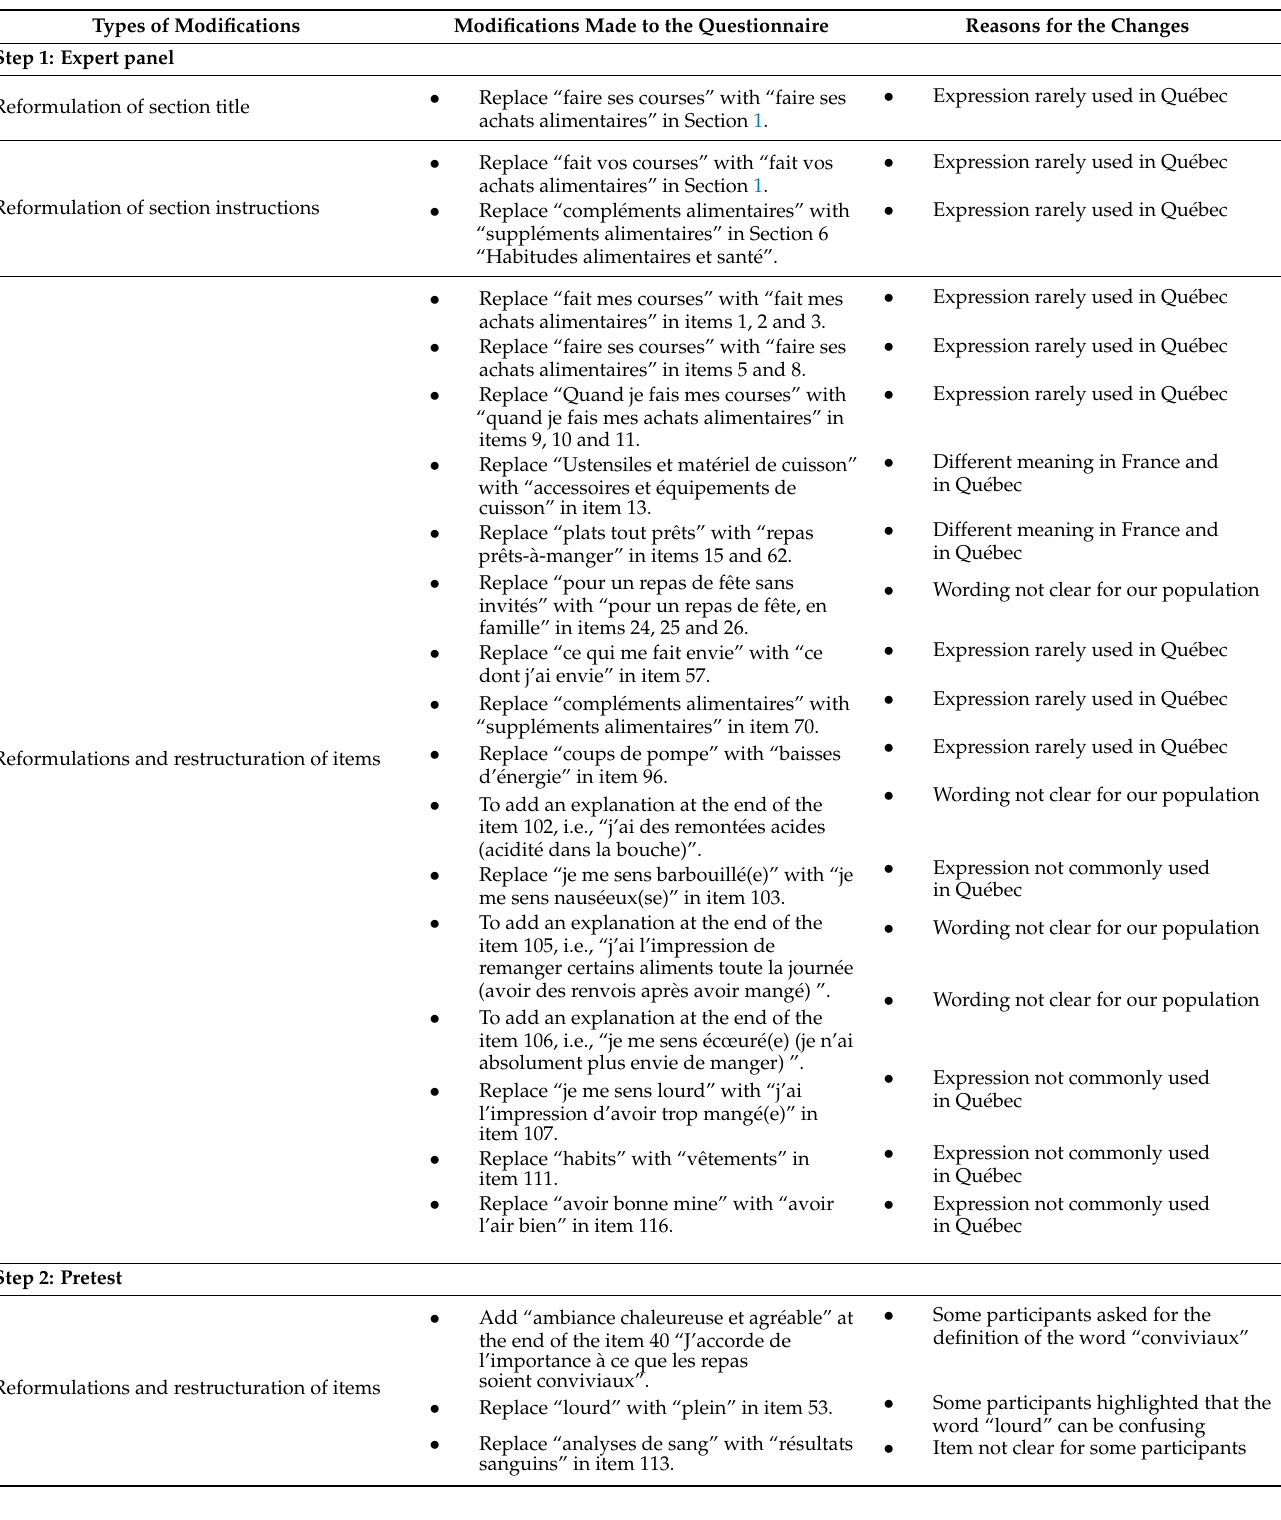
Table 1. Main changes made to the questionnaire during the adaptation